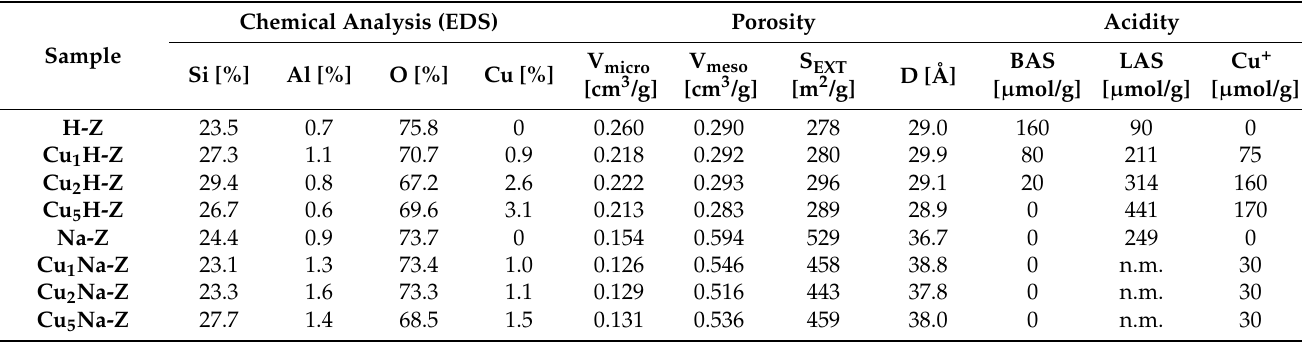
Table 1. EDS (Energy Dispersive Spectroscopy) chemical analysis, N 2 physisorption derived properties and the influence of Cu content on the concentration of active centers in the studied samples.